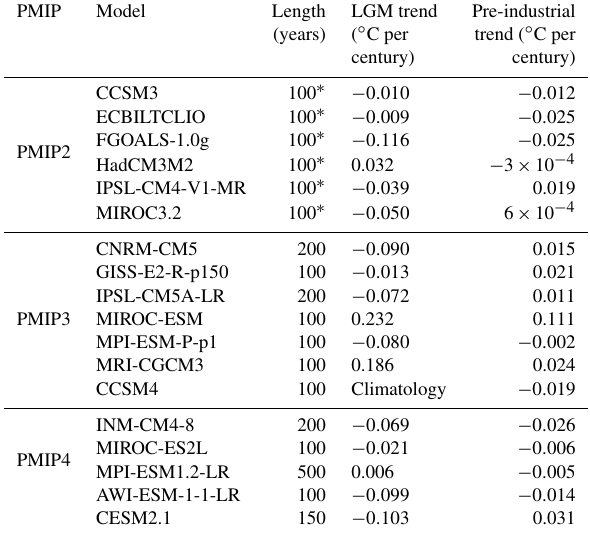
Table 3. Temperature trends in degrees Celsius per century for models of PMIP2, PMIP3 and PMIP4. For PMIP2, we report the results of Braconnot et al. (2007). Trends in PMIP3 and PMIP4 models are computed as the difference between the mean of the last 30 years and the mean of the first 30 years, normalized by simula- tion length. ∗ Simulations have a minimum length of 100 years but may be up to 200 years long (Braconnot et al.,